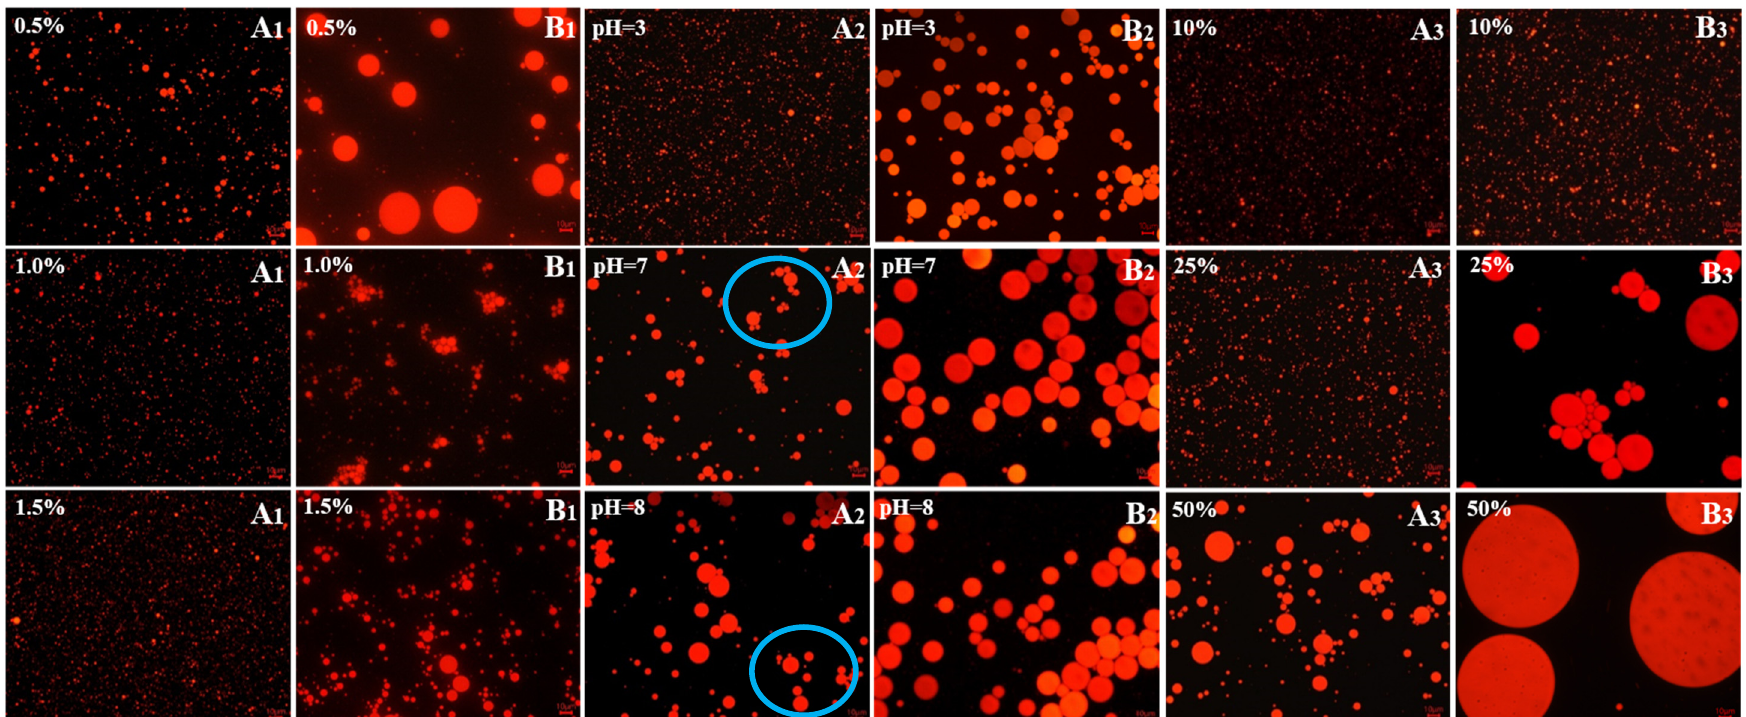
Figure 6. Digital photos of emulsions stabilized by MPP (A 1 , A 2 , A 3 ) and CCP (B 1 , B 2 , B 3 ) A 1 , B 1 : different pectin concentration; A 2 , B 2 : different pH; A 3 , B 3 : different oil ratio.